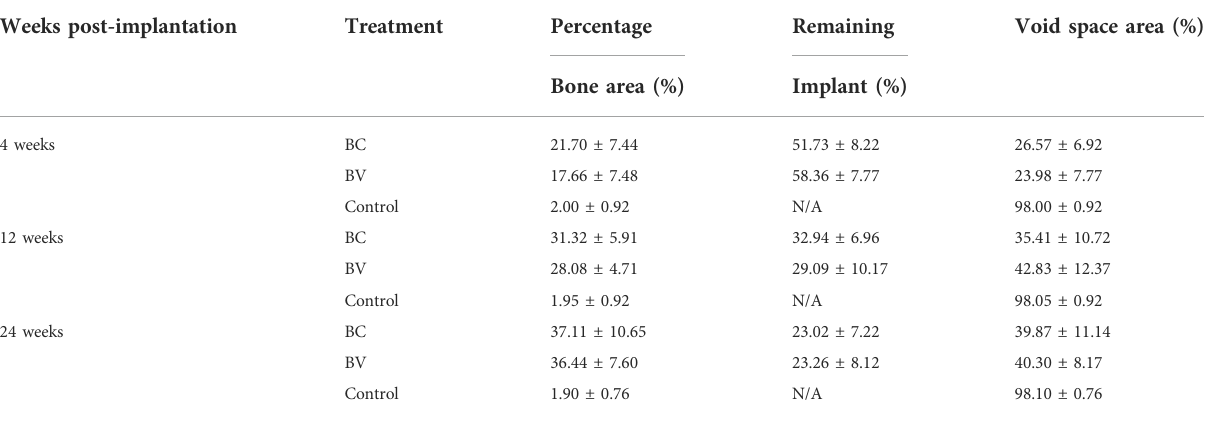
TABLE 3 Summary of histomorphometric